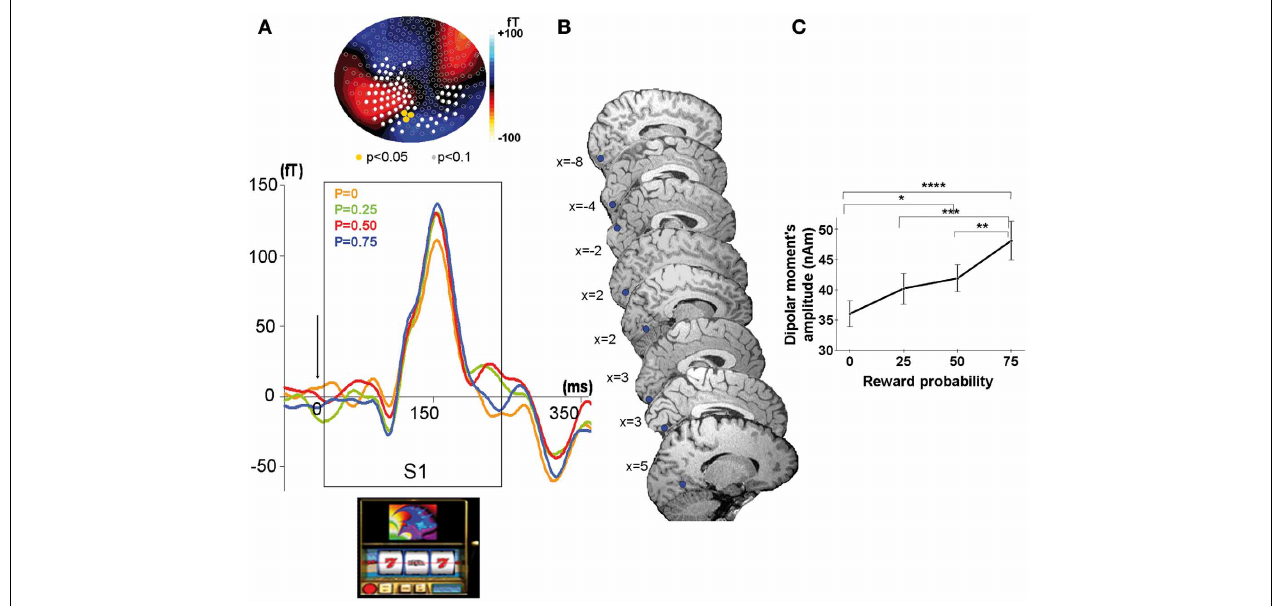
FIGURE 3 | MEG response sensitive to the conditioned stimulus at the time of the cue (S1). (A) Top: Scalp topography of the M150. Evoked related magnetic fields maps averaged across all participants showing a linear increase with reward probability at the time of the peak amplitude ( = 155ms) after cue presentation (S1). Color scale indicates the intensity of the magnetic field. Color dots indicate occipital sensors (sensors MLO11, MLO12, MLO22) where the ERFs showed a significant modulation by reward probability (Yellow dots: P < 0.05; white dots: P < 0 . 1). Bottom: Grand average MEG waveform on one selected occipital sensor in the left